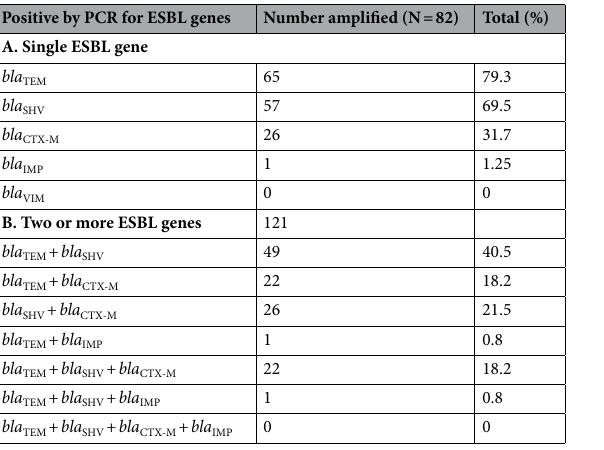
Table 2. ESBL genotypes in P. aeruginosa